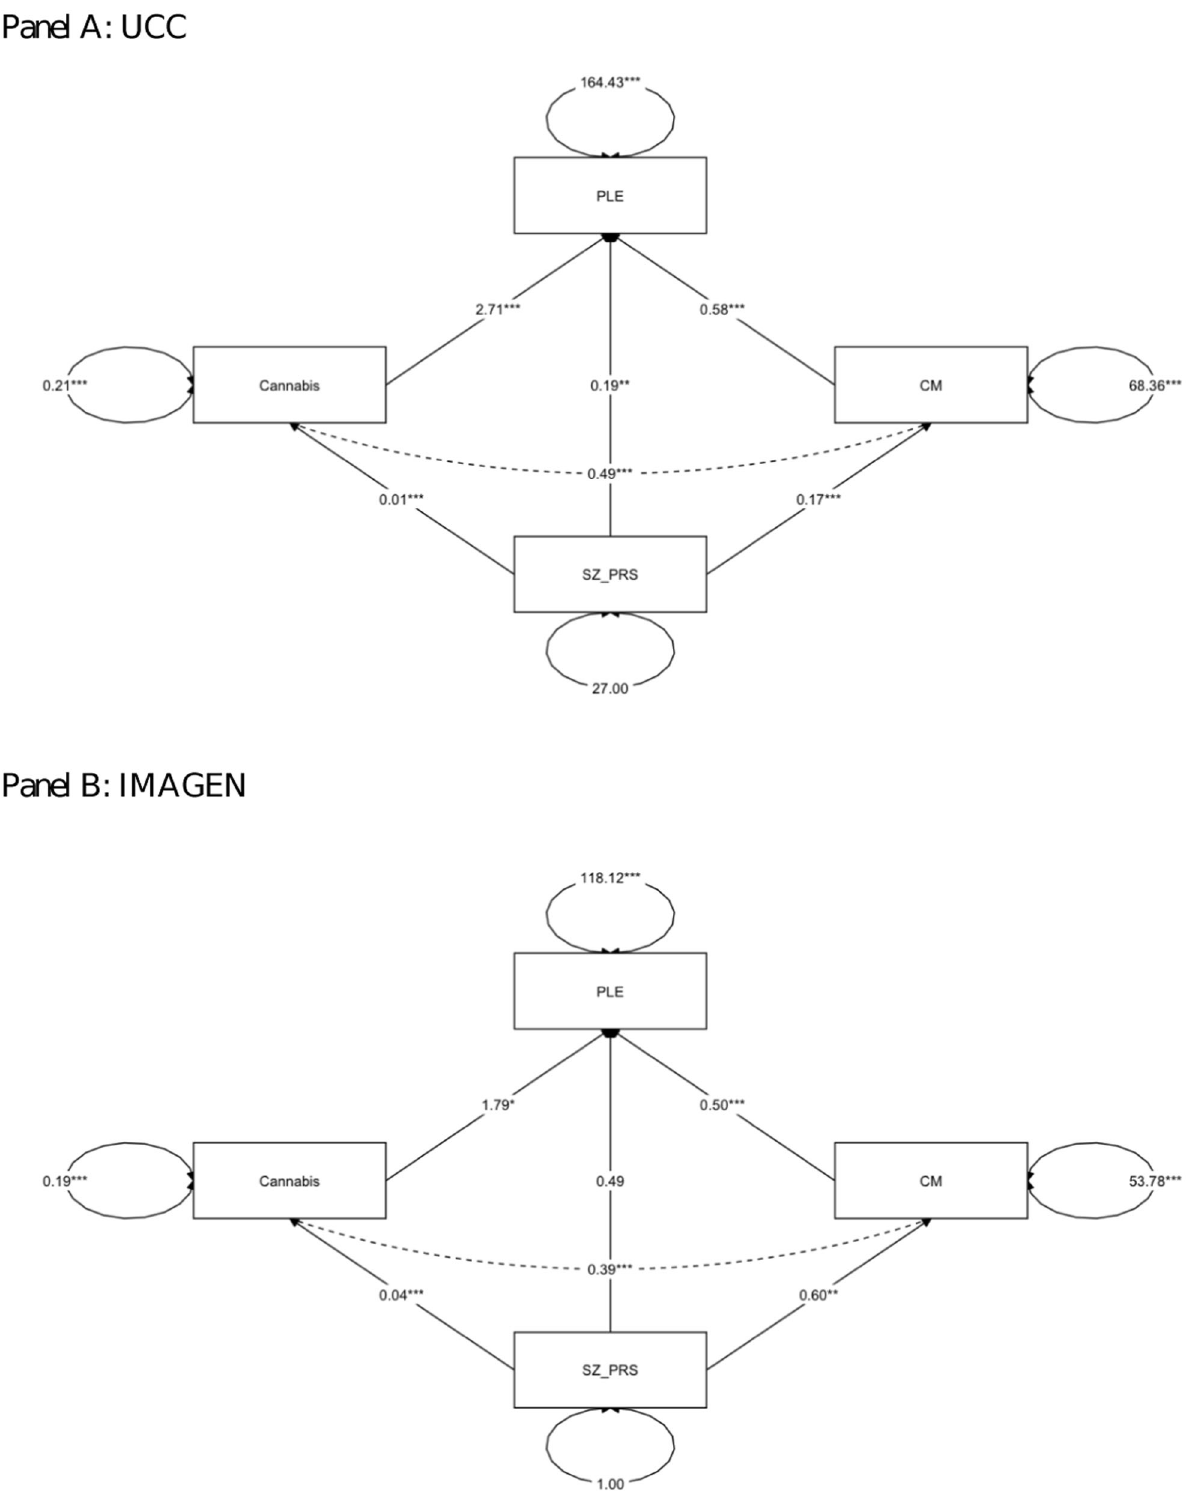
Fig. 1 Path diagram of parallel multiple mediator model in the discovery sample and in the replication sample. Panel A UCC, above; Panel B IMAGEN cohort, below. The estimates reported are the unstandardized regression coef fi cients. * p < 0.05; ** p < 0.01; *** p < 0.001. SZ-PRS schizophrenia polygenic risk score at p value threshold 0.5, CM childhood maltreatment, PLE psychotic-like